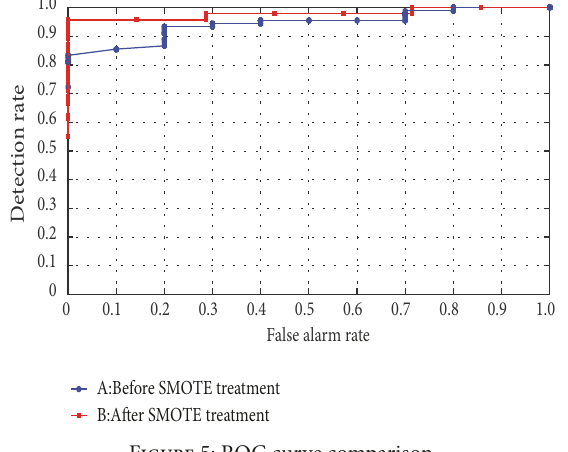
Figure 5: ROC curve comparison.